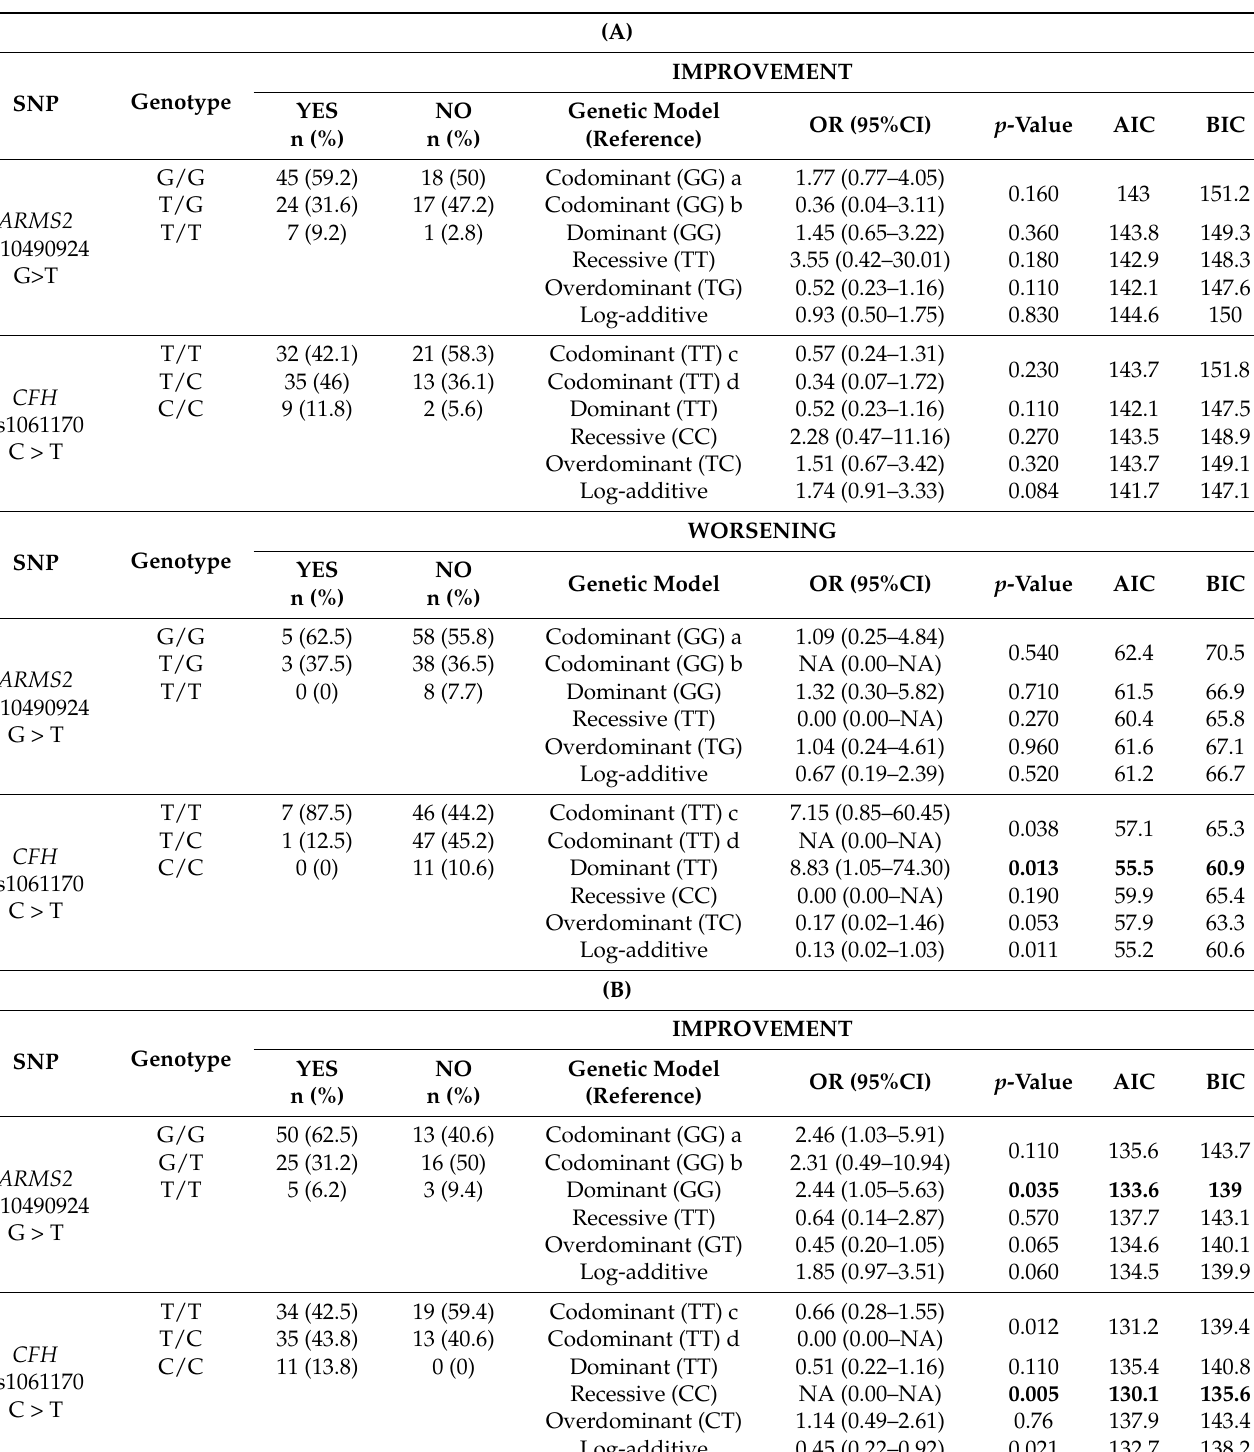
Table 5. ( A ). ARMS2 (rs10490924) and CFH (rs1061170) genotype association with BCVA improvement/worsening at 1 month. ( B ). ARMS2 (rs10490924) and CFH (rs1061170) genotype association with BCVA improvement/worsening at 6